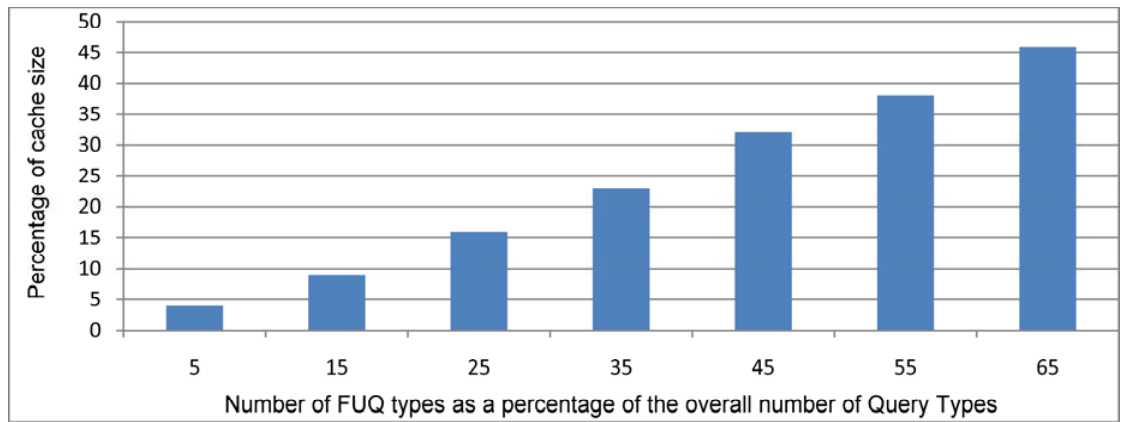
Fig. 11: Percentage of cache size needed to store variable percentage of FUQ